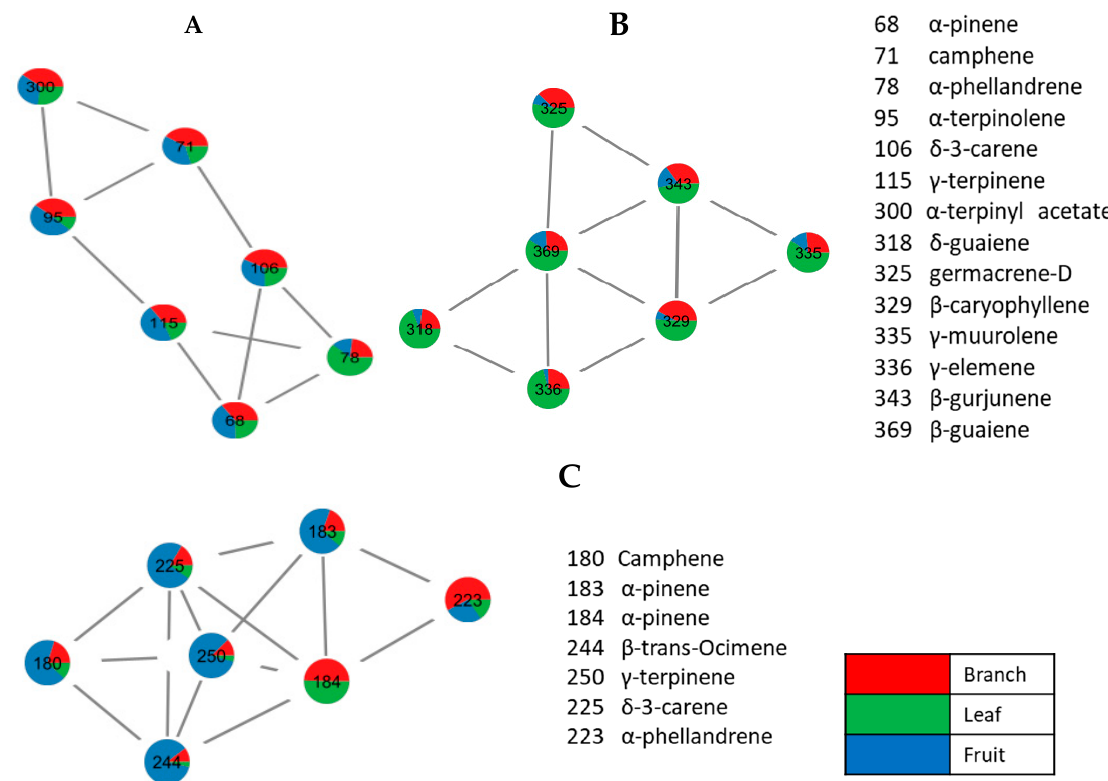
Figure 4. Molecular networks of monoterpenes and sesquiterpenes predicted based on spectral similarity. Each node represents a compound and the pie chart within each node, showing red, green and blue segments, represent its relative abundance determined in branch, leaf and fruit, respectively. ( A ) Molecular network of monoterpenes obtained for essential oils extracted by microwave and Clevenger hydrodistillation; ( B ) molecular network of sesquiterpenes obtained for extracted essential oils using microwave and Clevenger hydrodistillation; ( C ) molecular network of monoterpenes obtained for volatiles produced during headspace sampling.